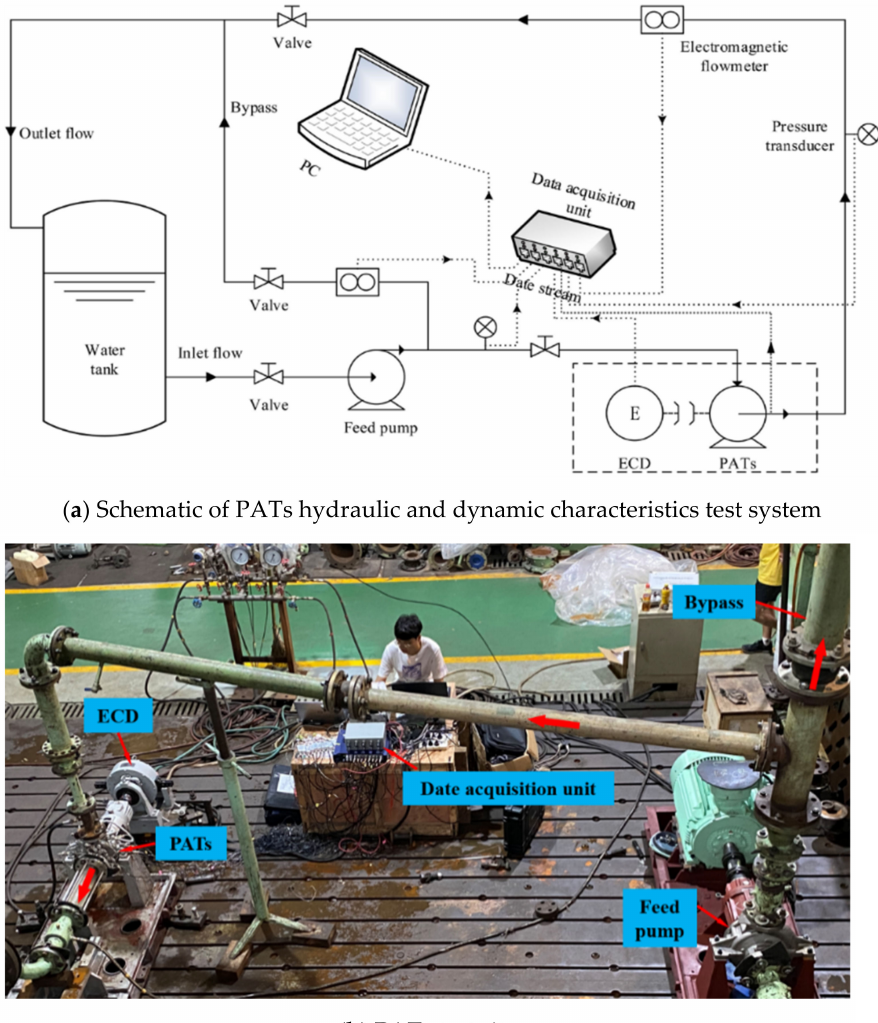
Figure 5. PATs test